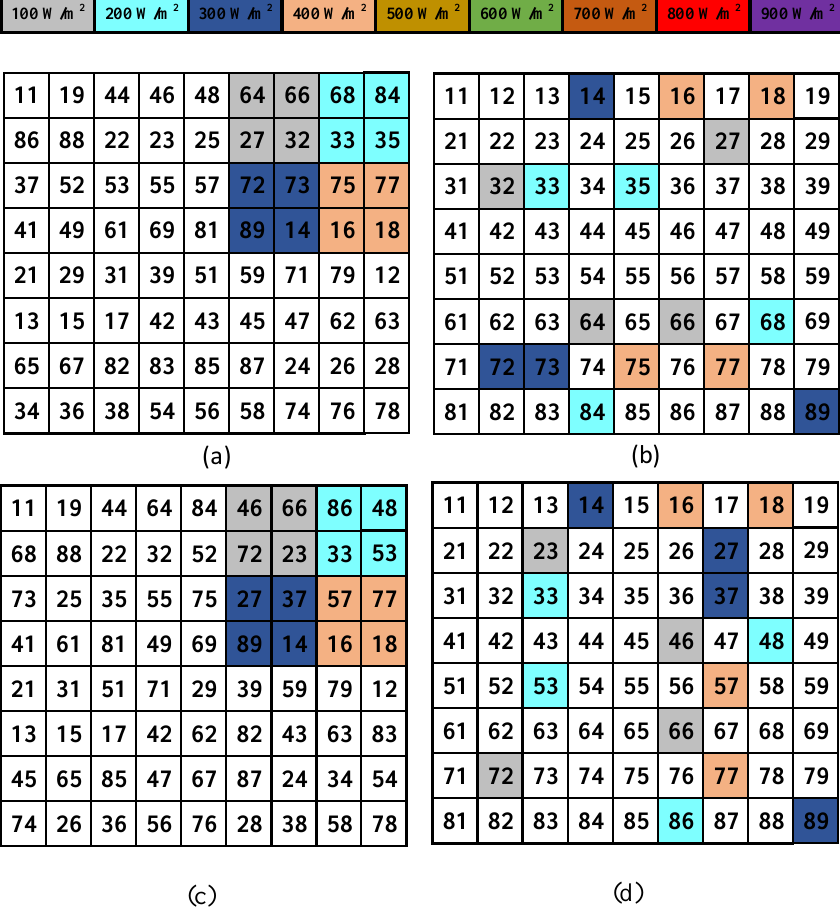
Figure 18. ( a ) OEP; ( b ) shade dispersion of OEP; ( c ) IOEP; and ( d ) shade dispersion of IOEP for 8 × 9 PV array at Top-Right PSC. The voltage–power characteristics of case-2 (Top-Right) are shown in the Figure 19. From the voltage–power characteristics it understood that IOEP reconfiguration has a superior performance under partial-shading conditions.